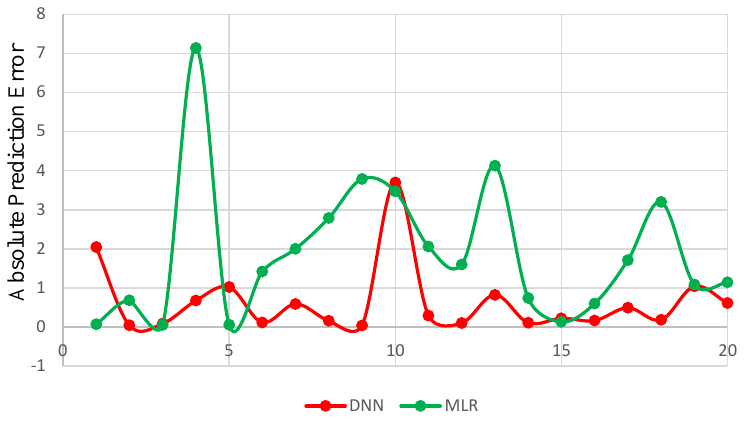
Figure 5. Results of absolute error for actual and predicted values using DNN and MLR